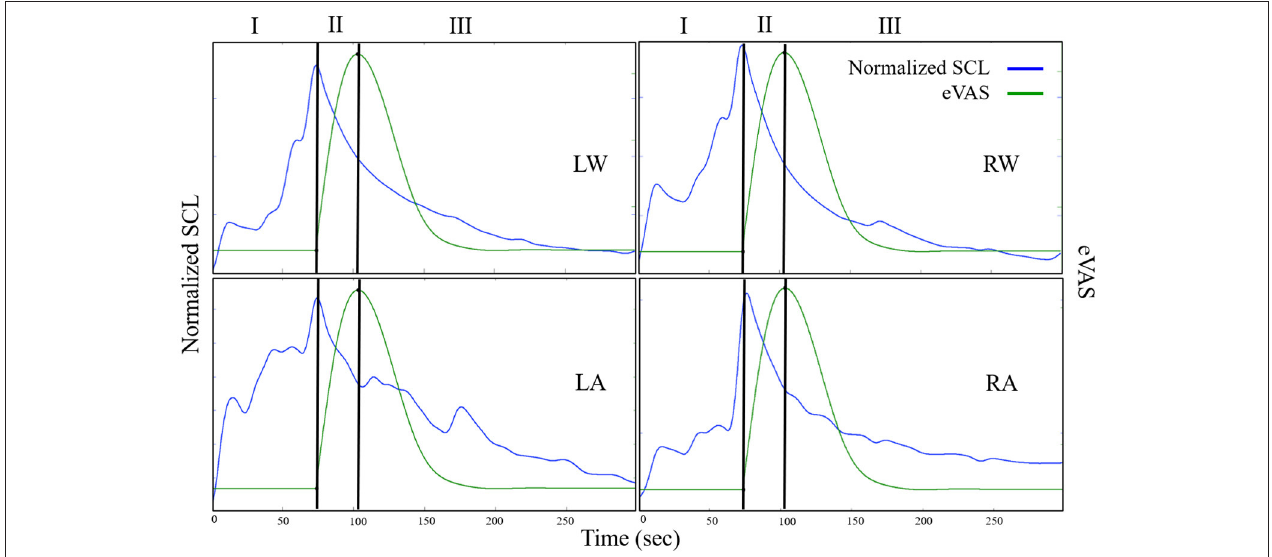
FIGURE 2 | Examples from one person illustrating SCL (blue) and eVAS (green) during the Capsaicin segment for the left wrist (LW), right wrist (RW), left ankle (LA) and right ankle (RA). Region I starts when the person is told that the capsaicin treatment is next, and ends when the needle is inserted. Region II starts with needle insertion and continues until the person’s self-reported eVAS reaches a peak. Region III is measured from the peak eVAS until 15min after the onset of the capsaicin treatment. Region III for Capsaicin usually contains decreasing values of SCL, as in the examples shown here.